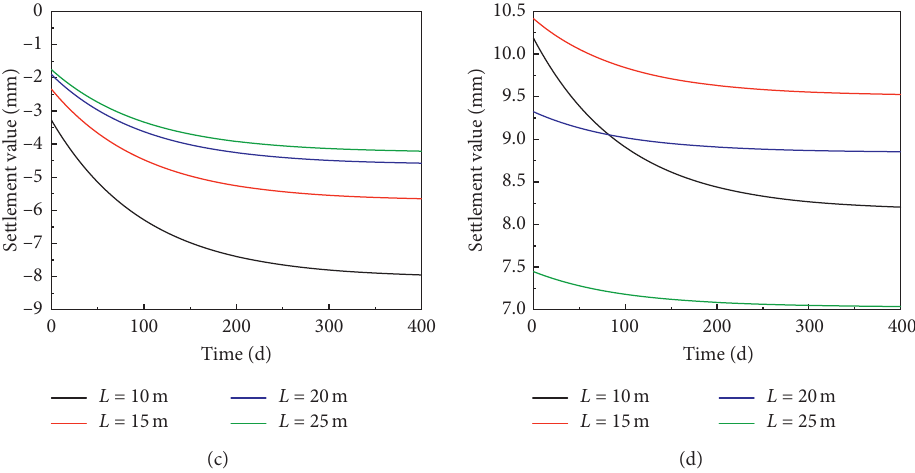
Figure 10: Different tunnel spacing causes a change in the ground settlement at points (–10, L /2, 0) with time under the action of the support pressures (a), shield shell frictions (b), grouting pressures (c), and total displacement over time